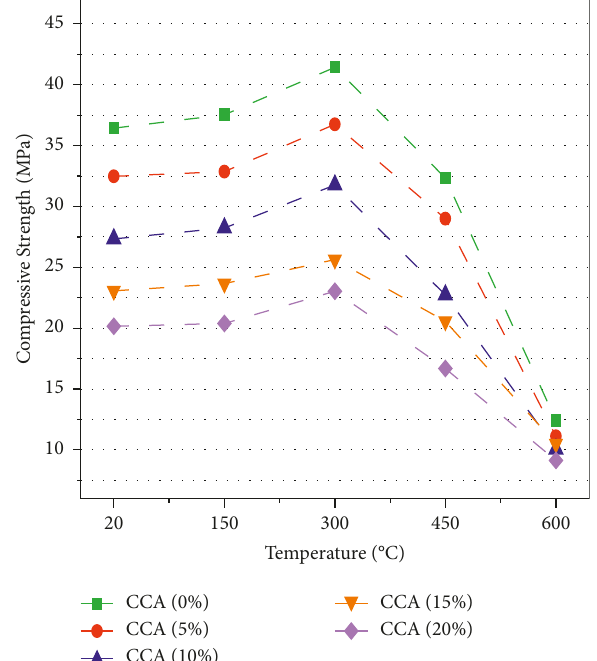
Figure 19: Compressive strength of concrete with CCA at varying elevated temperatures [43].